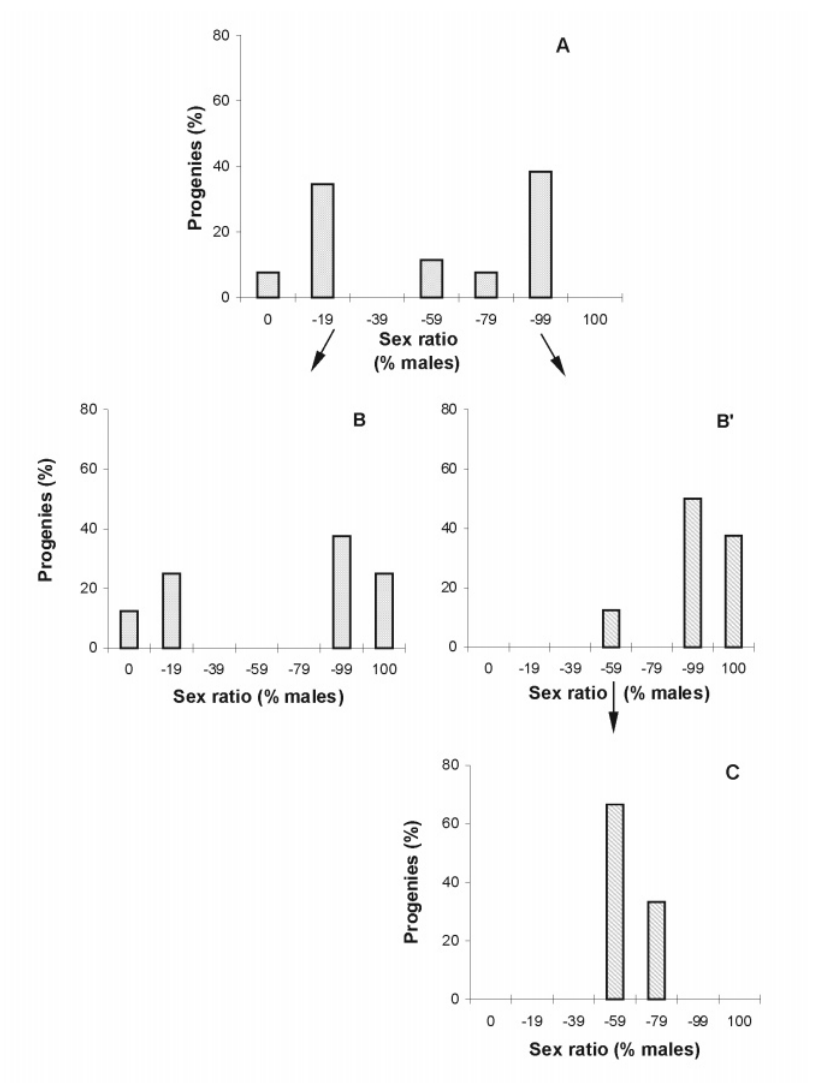
Figure 2 - Sex ratio distribution of progenies produced by females from female-skewed or male-skewed progenies. Females (N = 26) recovered from a bisexual progeny (27 male:70 females) produced the progenie classes shown in A. Females selected from the progeny interval 1-19% produced the female- and male-skewed progenies shown in B. In contrast, females collected from a predominantly male progeny (interval 80- 99%) produced bisexual and male-skewed progenies (B’). Females selected from the bisexual class in B’ produced only bisexual progenies